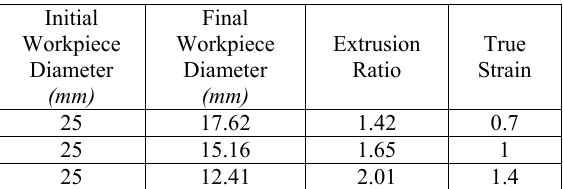
Table 1. The summary of extrusion experiments.